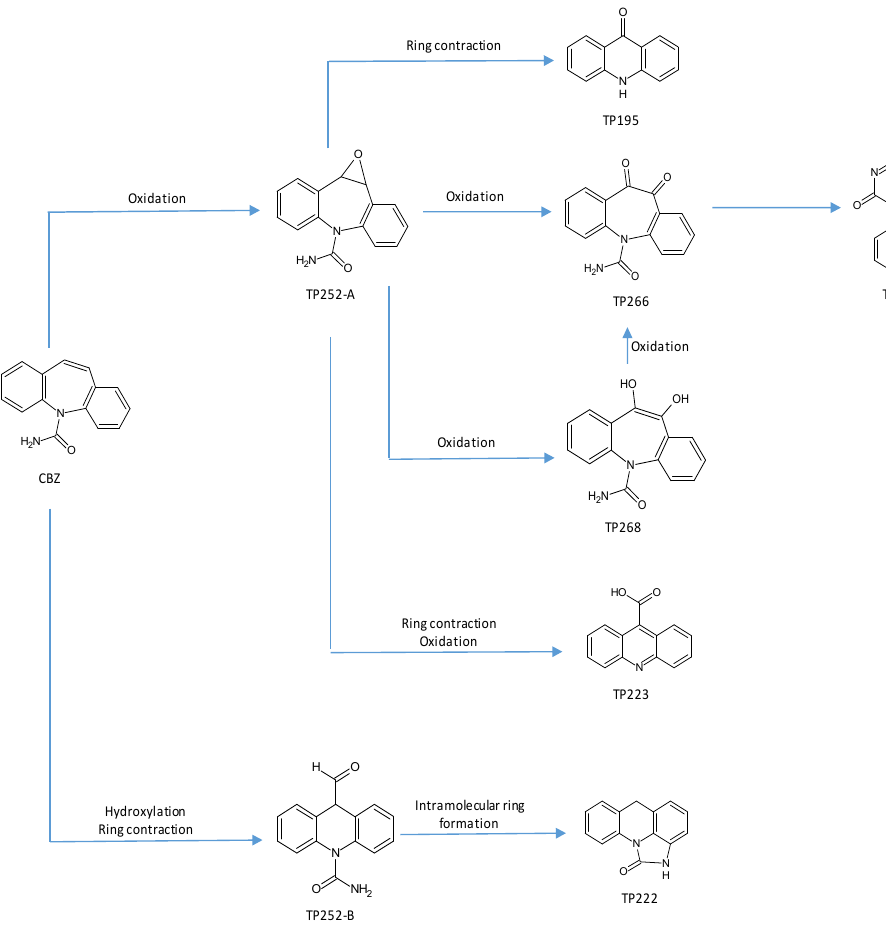
Figure 3. Proposed degradation pathway.